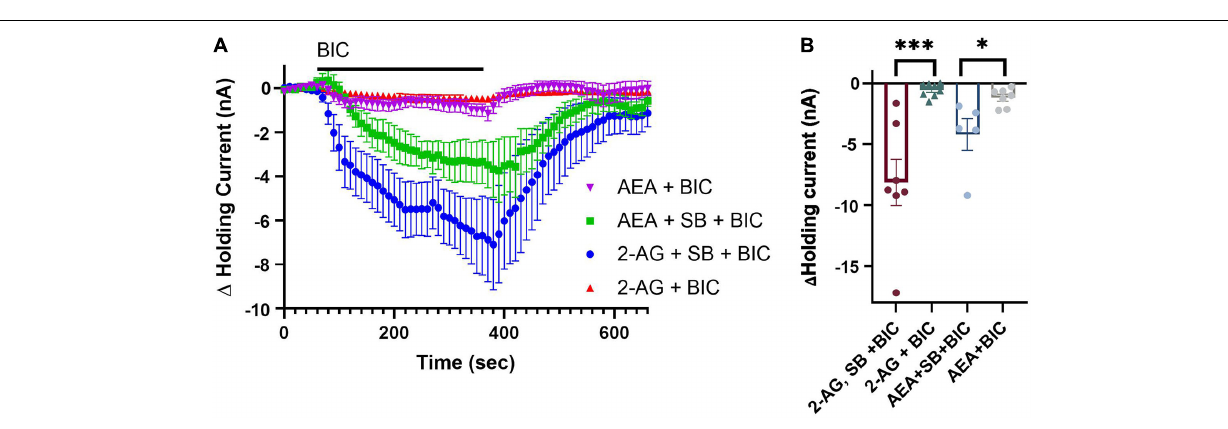
FIGURE 5 | TPRV signaling mediates 2-AG- and AEA-induced depression of tonic inhibition. (A) Co-application of 100 µ M 2-AG with 10 µ M SB is able to prevent 2-AG-induced depression of tonic inhibition onto the P cell. A total of 10 µ M SB was also able to block the 0.1 µ M AEA-induced depression of tonic inhibition. (B) In terms of peak current, the 2-AG + SB + BIC group was significantly different from the 2-AG + BIC group while the AEA + SB + BIC group was significantly different from the AEA + BIC group (* indicates p < 0.05; *** indicates p < 0.001). All data is shown as mean ±